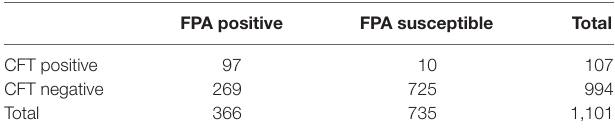
tABLe 1 | Calculation of the agreement between fluorescence polarization assay (FPA) and Complement Fixation Test (CFT) observations by the Cohen’s Kappa